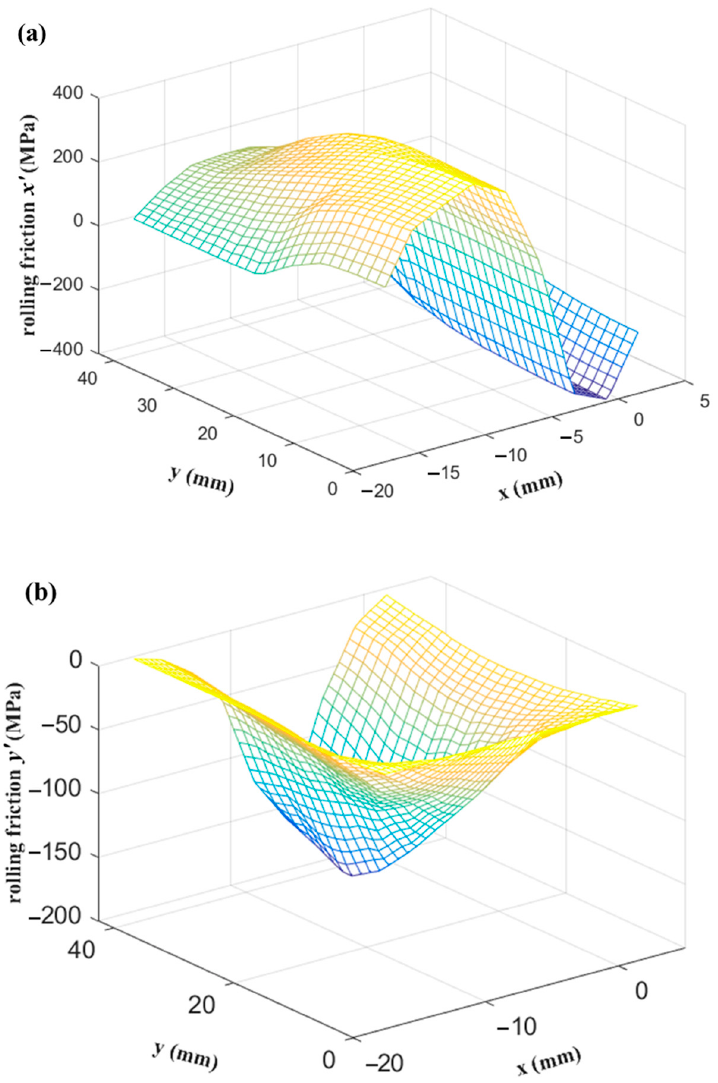
Figure 9. Distribution of rolling friction obtained using FE analysis in the contact area in the ( a ) x (cid:48) direction and ( b ) y (cid:48) direction.